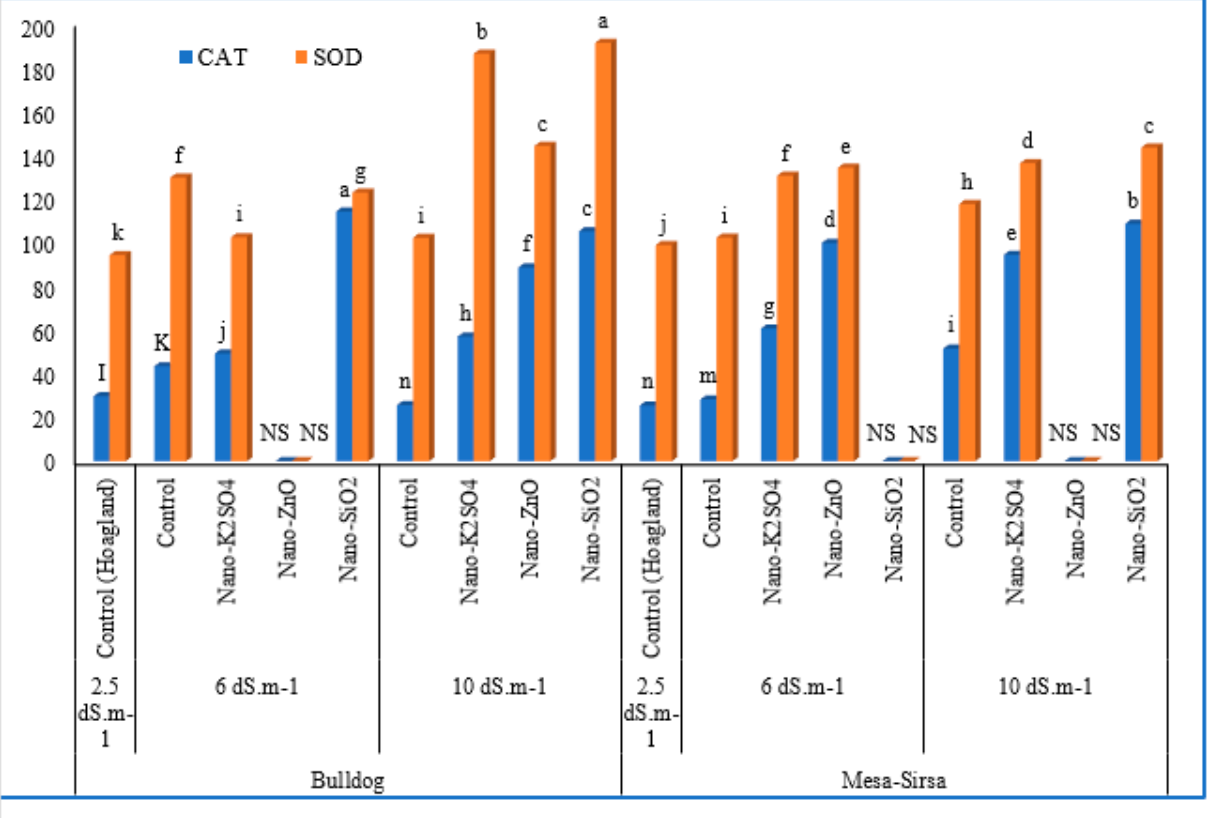
Figure 2. Effect of different Nano- fertilizers (K 2 SO 4 , ZnO, and SiO 2 ) on catalase (mmol H 2 O 2 min − 1 g − 1 FW) and SOD (Super oxide dismutase in U. g − 1 FW) of Alfalfa genotypes grown under three salt levels (control “Hoagland”, 10 and 15 dS m − 1 electrical conductivity). NS: no sample. The column values with the same letters are statistical similar according to Duncan Multiple Range Test (DMRT) at p <